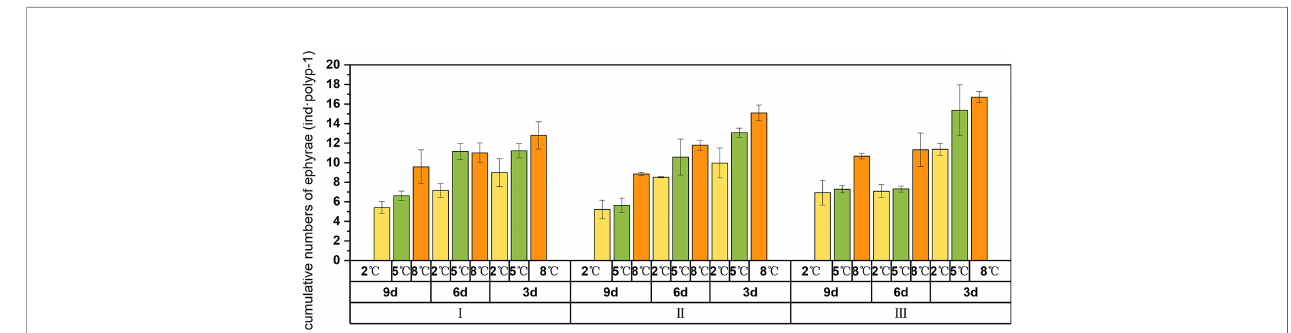
FIGURE 4 | Cumulative numbers of ephyrae per polyp in 27